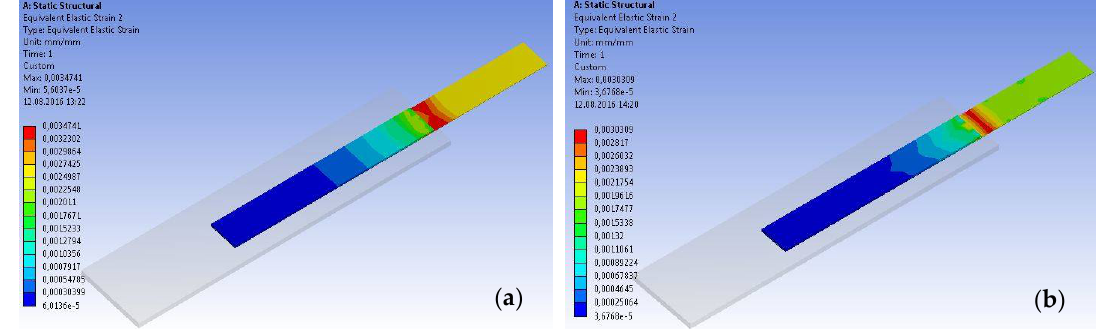
Figure 22. Typical strain distribution maps at the level of the CFRP strip: ( a ) S-S512-30-3 and ( b ) S-M514-30-3 types.